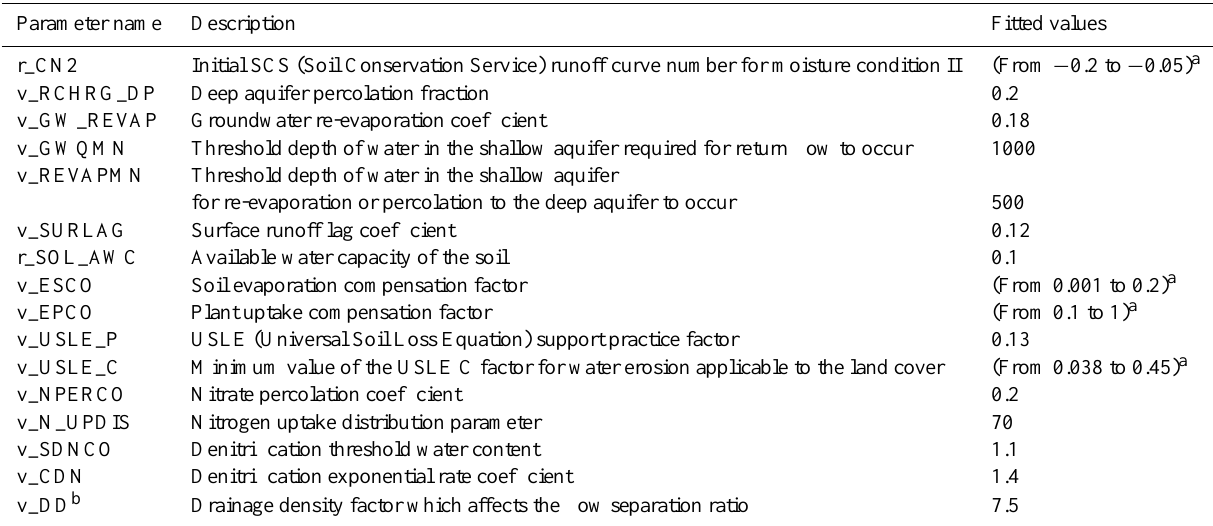
Table 3. Description of calibrated parameter values of the SWAT Landscape model. Superscript a indicates that the fitted values depended on the land cover type. Superscript b indicates that this parameter was used only in the calibration of the grid-based SWAT Landscape model. Subscript v_ indicates that the parameter value is replaced by the fitted value. Subscript r_ indicates the parameter value is multiplied by (1 + the fitted